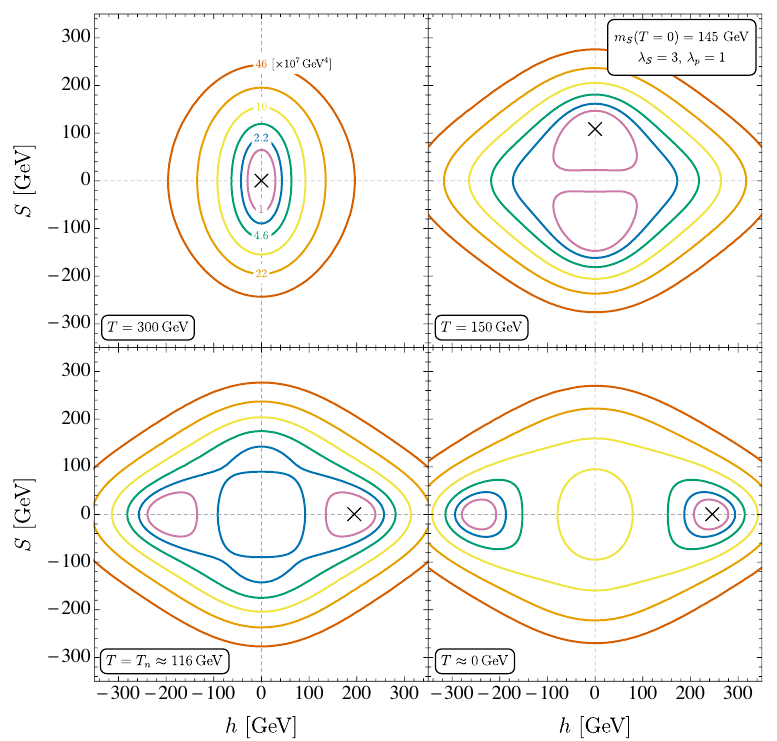
Figure 2 . The e(cid:11)ective potential V e(cid:11) at T = 300 GeV (top-left), at T = 150 GeV (top-right), the nucleation temperature T = T n (cid:25) 116 GeV (bottom-left) and T (cid:25) 0 GeV (bottom-right). In each plot we subtract a constant, the minimum value of the potential, to highlight the features around the minima. The black cross indicates the phase the Universe is in at the given temperatures.